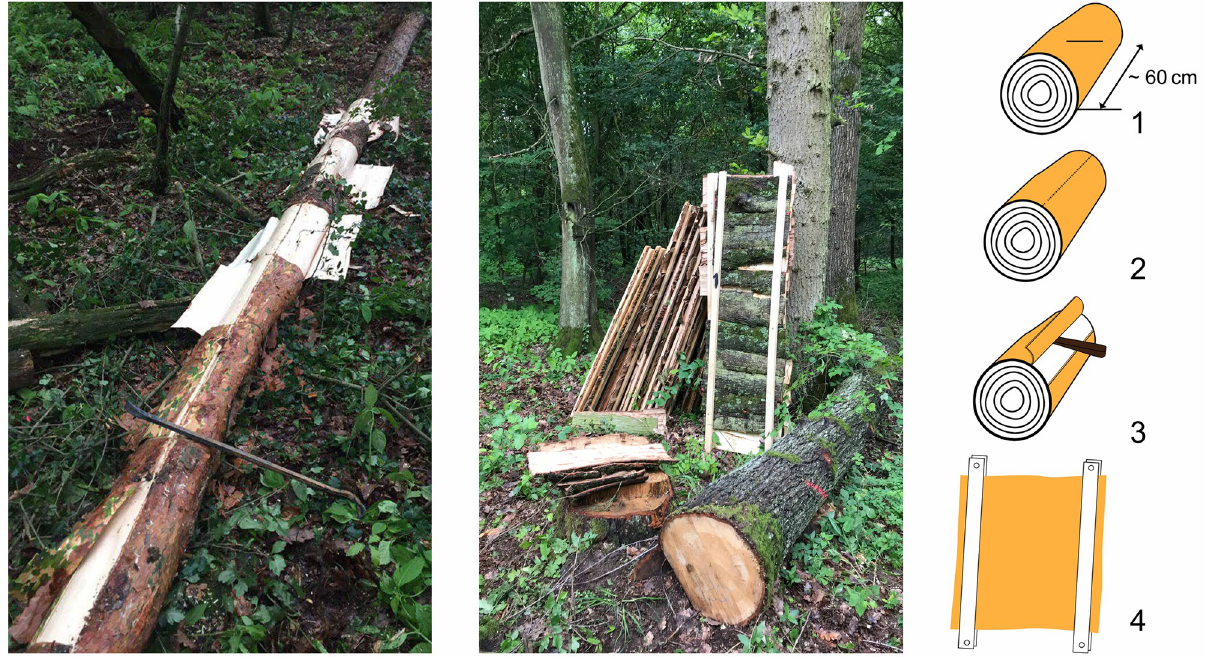
Fig 1. Process of bark peeling (left), a pile of drying bark fixed between a wood construction (middle) and peeling process (right). (1) cut of the stem into needed length for bark peeling. (2) by creating a longitudinal cut, the bark including bast and cambium becomes a starting point for the peeling (3) by hand or with a handle, the bark is removed in one piece (4) freshly cut bark is fixed for drying.